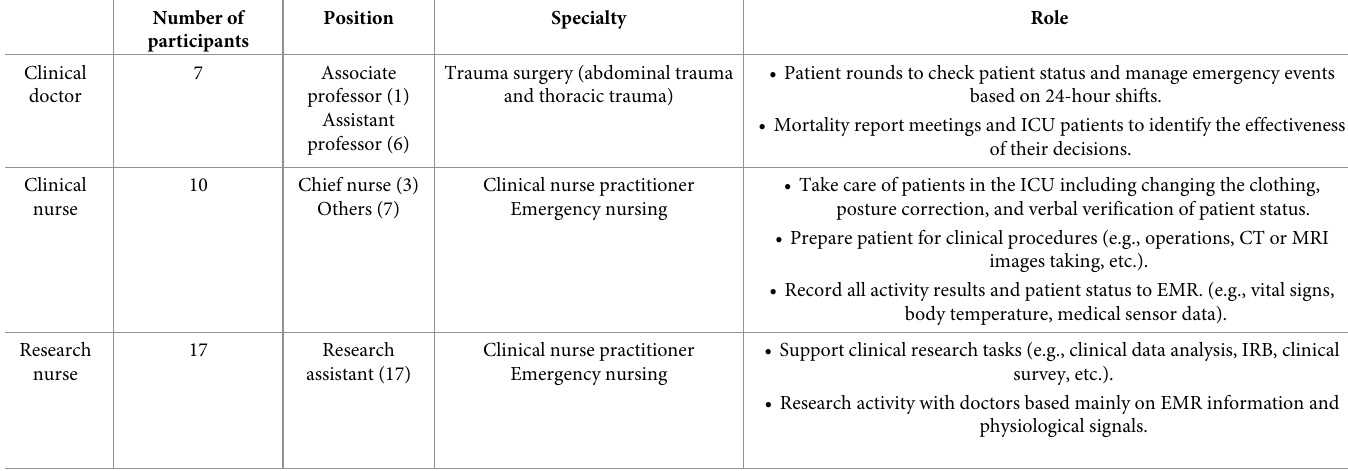
Table 1. Summary of user groups’ seniority, specialty, and role at an urban university hospital’s trauma center. We introduce how each user’s role is different follow- ing their daily routine in Section 4. Number of